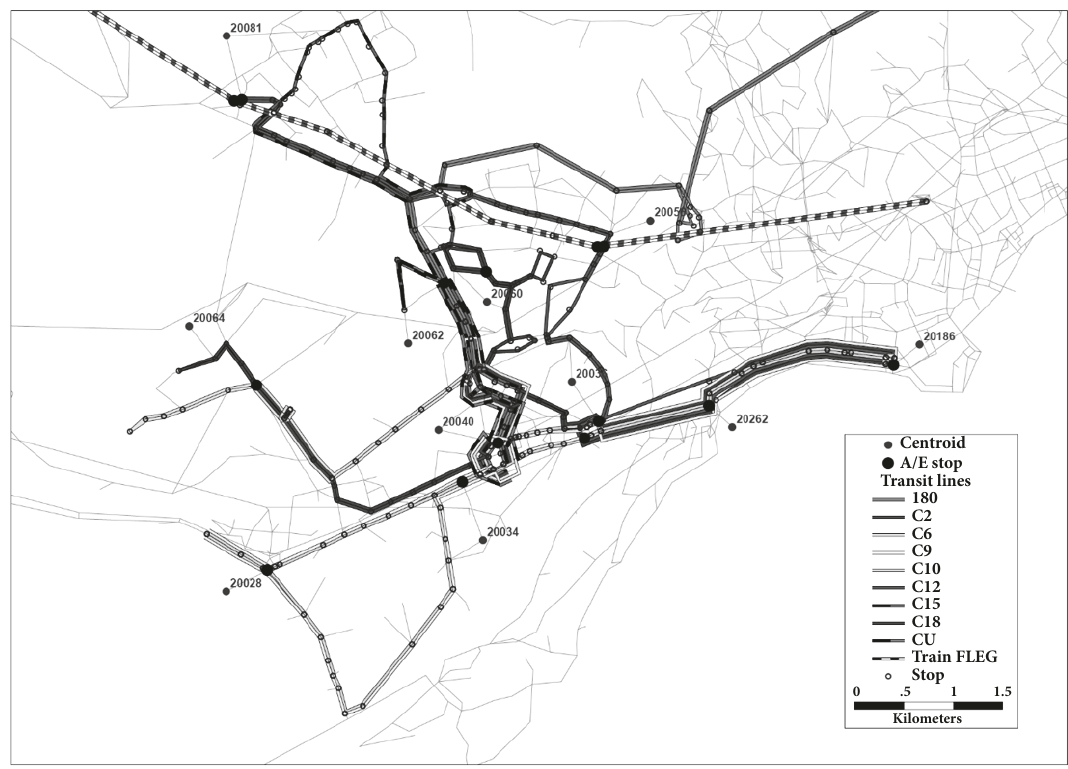
Figure 4: The application network